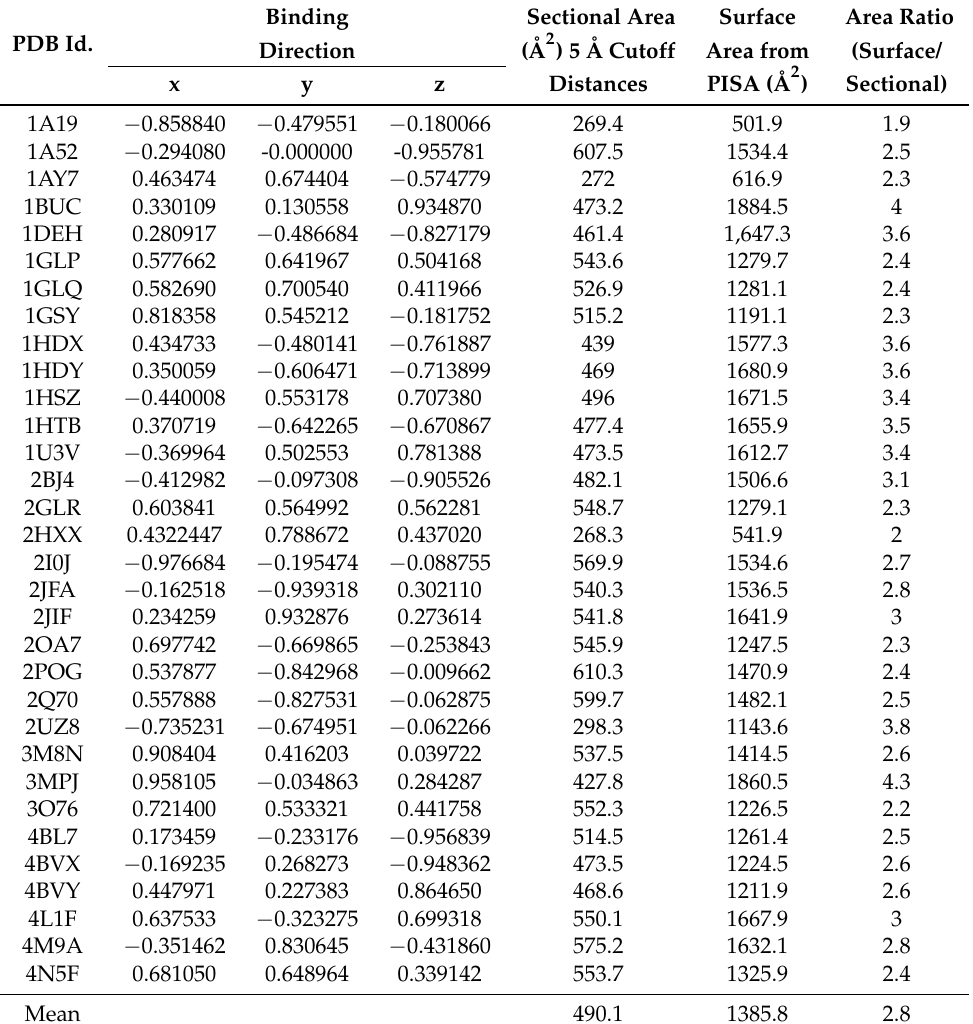
Table 1. Computed binding directions and area